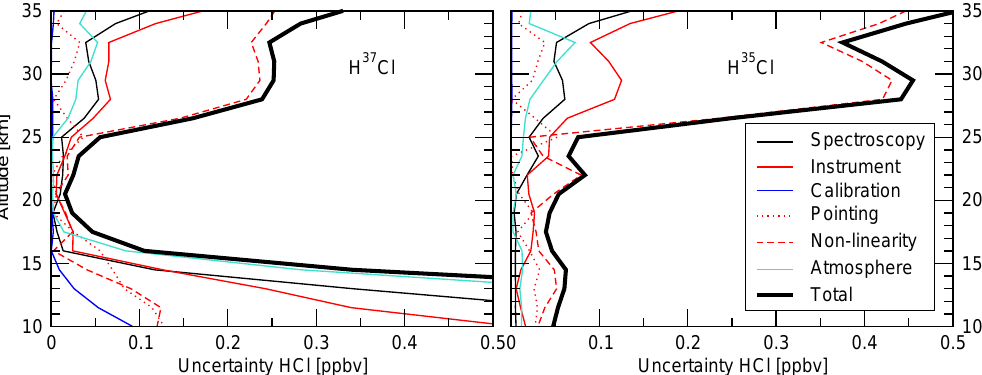
Fig. 6. The individual estimates of systematic effects in the HCl profiles based on the H 37 Cl line (left panel) and the H 35 Cl line (right panel). Several systematic error sources have been grouped together. In black the spectroscopic error is given for uncertainties in the spectral widths and line strengths of the HCl lines. In red the errors of various instrumental uncertainties are shown; the solid red line combines the errors due to uncertainties in field of view, local oscillator frequency, instrumental line shape, and sideband ratio, the dotted red line refers to the absolute pointing, and the dashed red line to the non-linearity of the detector response function. In blue the systematic error due to the radiometric calibration is given and in turquoise the systematic error by uncertainties in the atmospheric condition (temperature and pressure profiles). The thick black line is the RSS of these errors.